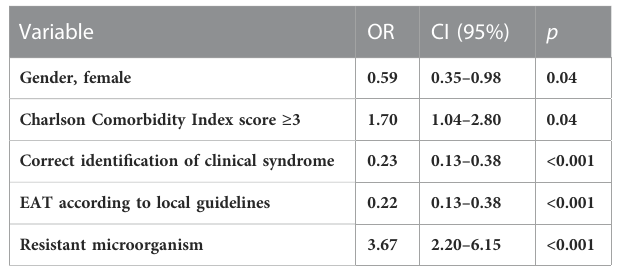
TABLE 5 Multivariate